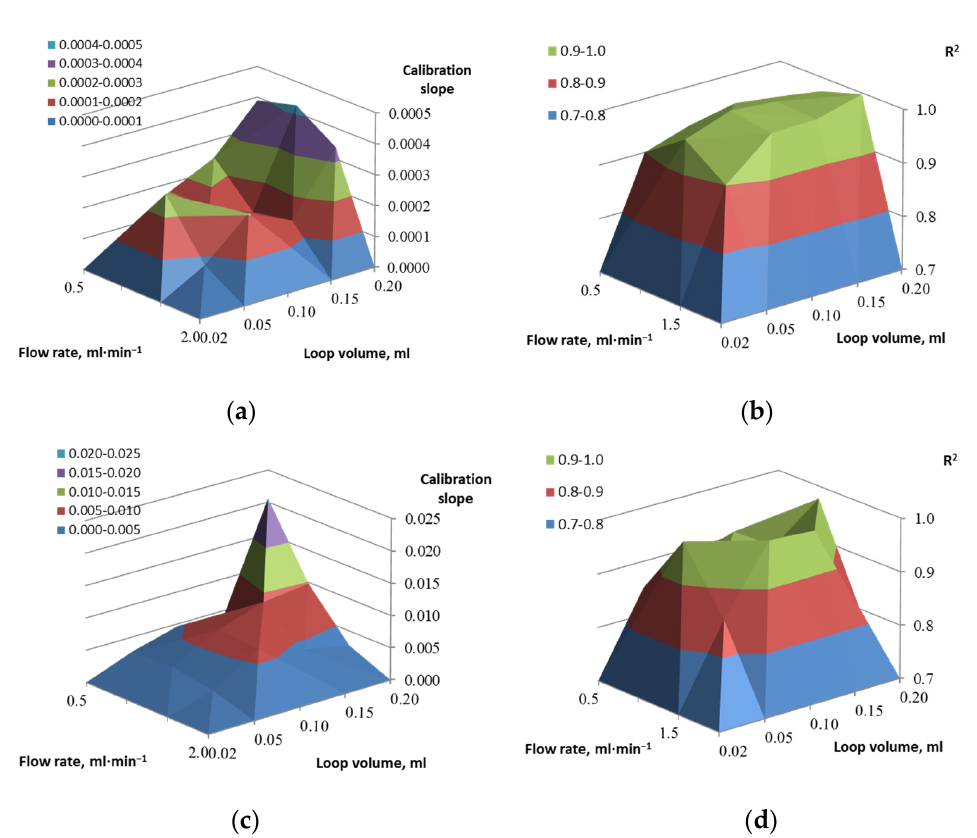
Figure 7. Influence of loop volume and flow rate on the system performance: ( a )—calibration slope and ( b )—coefficient of mixed correlation dependencies for Clark electrode; ( c )—calibration slope and ( d )—coefficient of mixed correlation dependencies for optical oxygen sensor.